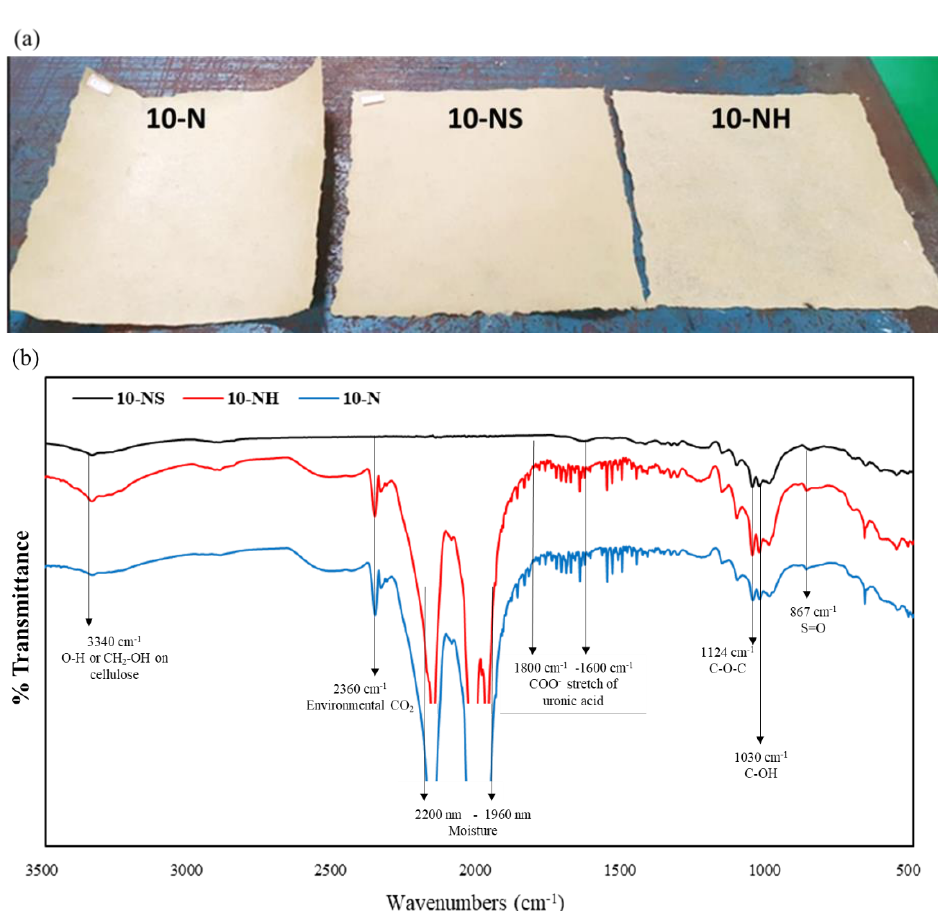
Figure 7. ( a ) Visual appearance and ( b ) FTIR spectra of Rhizoclonium pulp samples prepared using 10-N, 10-NH, and 10-NS cooking treatments in